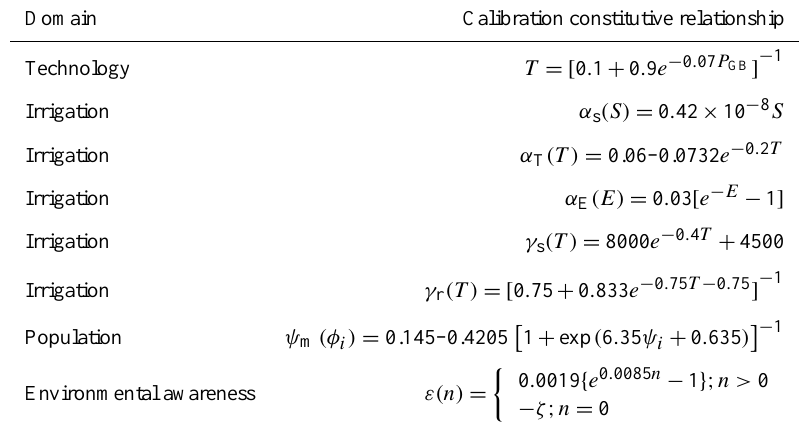
Table 3. Calibrated constitutive relations needed to complete model